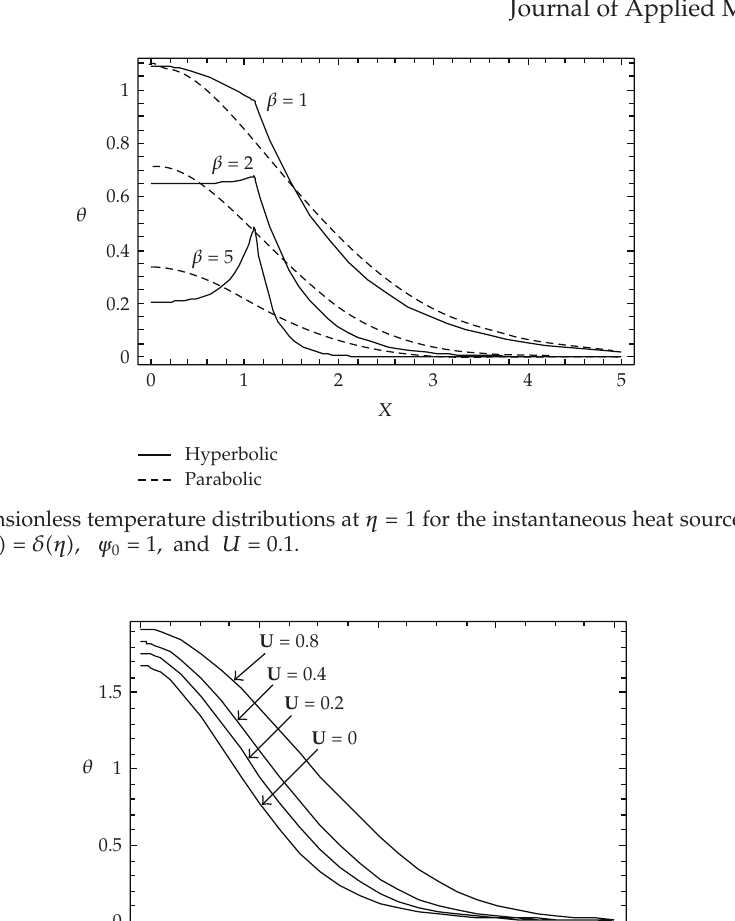
(cid:5) 1 , β (cid:5) 1 , and η (cid:5) 3 . 0